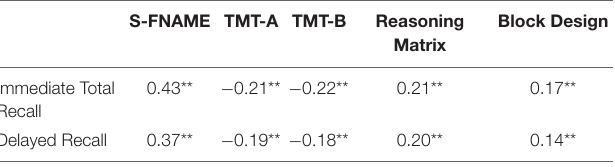
TABLE 3 | Rey Auditory Verbal Learning Test factor structure obtained from EFA. Rotated components matrix